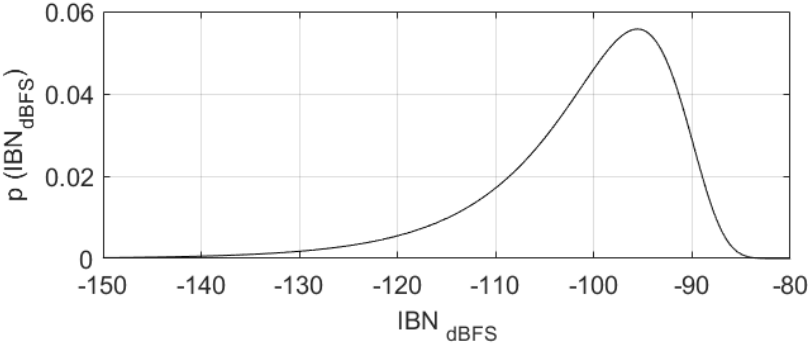
Figure 13. IBN power in NP regions PDF (in dBFS ) for a third-order Σ∆ M with 4-bits, fs = 2.32 MHz, BW = 20 kHz, OSR = 58, OBG = 1.8, and σ T =